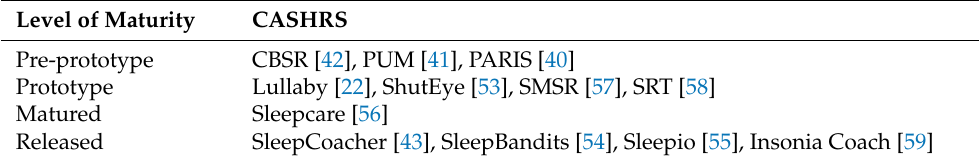
Table 8. Maturity of the reviewed